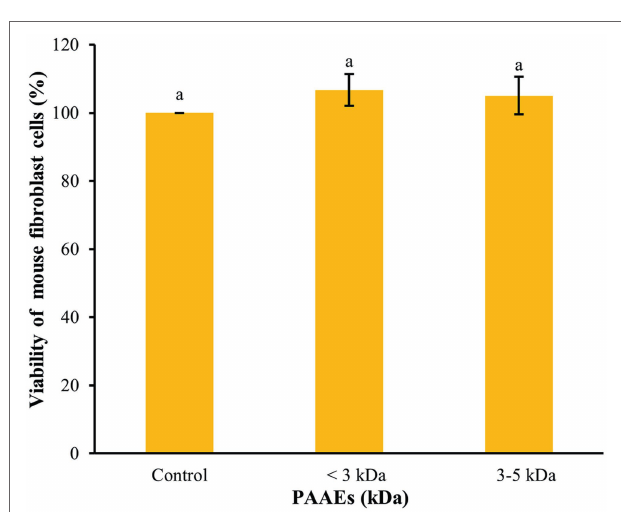
FIGURE 5 | The activity of PAAEs (MW < 3 and 3–5 kDa, IC 50 values) on cytotoxic to normal mouse fibroblast cells (L929). The results were expressed as mean with SD of triplicates from three independent studies. a The values with different letters appearing show significant differences ( p >